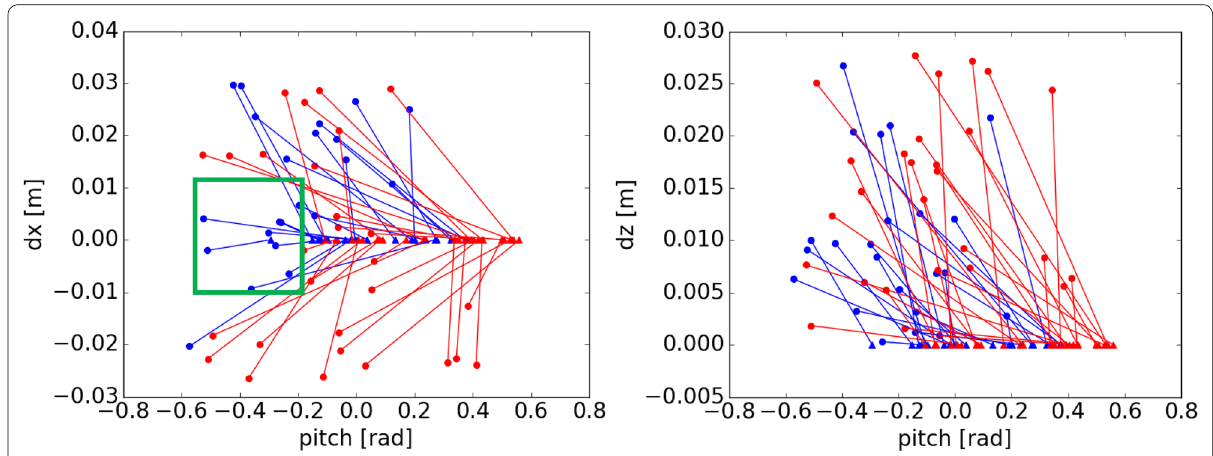
Fig. 13 Examples of fine adjustment for grasp point detection ( β v < β g )